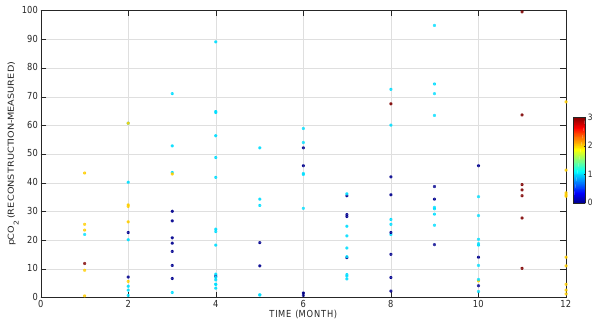
Figure 16. Absolute difference between p CO 2 reconstructed and p CO 2 measured in function of the month. The colour bar corre- spond to the number of empty parameter before the reconstruction (blue: 0 missing data; light blue: 1 missing datum; yellow: 2 missing data; red: 3 missing data). Table 6. Coefficient of correlation ( R ) between the measured p CO 2 and the p CO 2 data estimated and the SD for the model and the data in function of the number of missing parameters. R rms